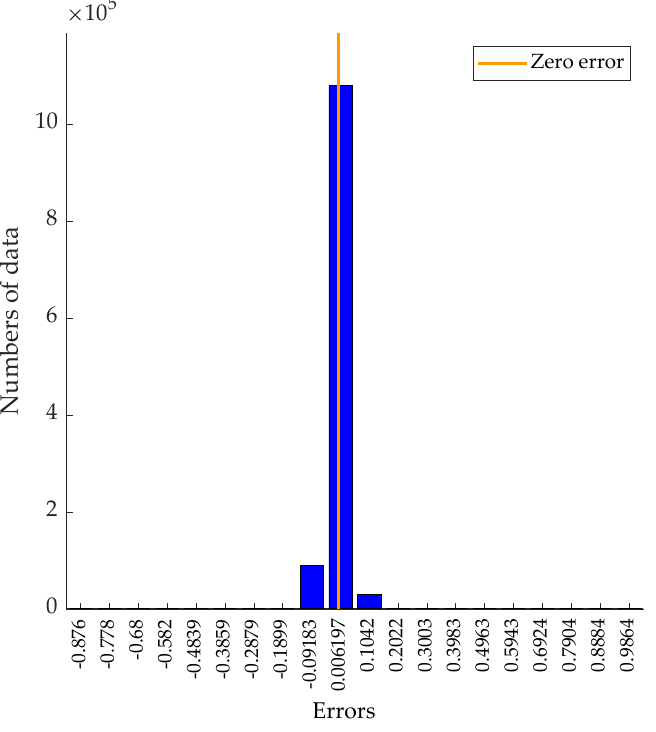
Figure 10. Error histogram of the validating process.